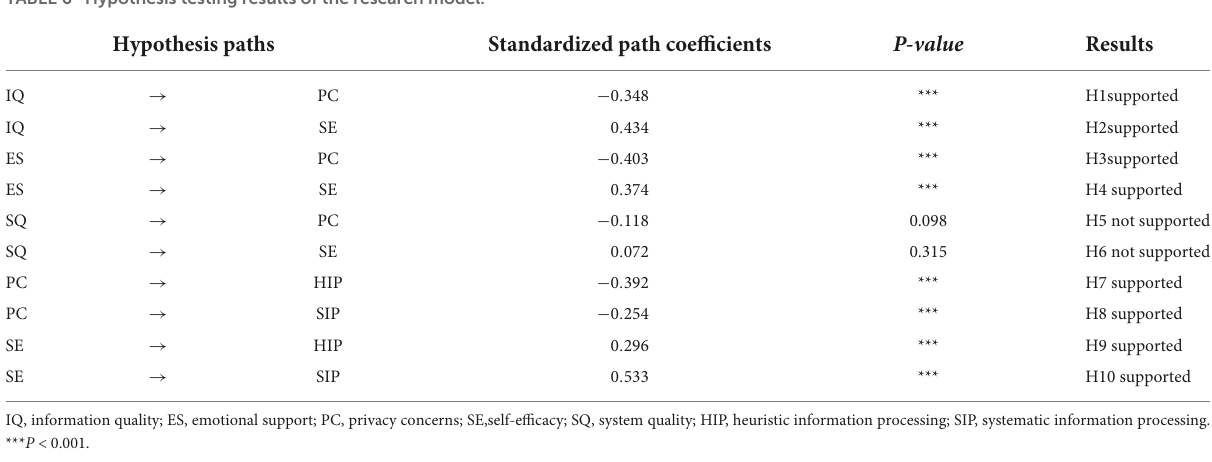
TABLE 6 Hypothesis testing results of the research model.